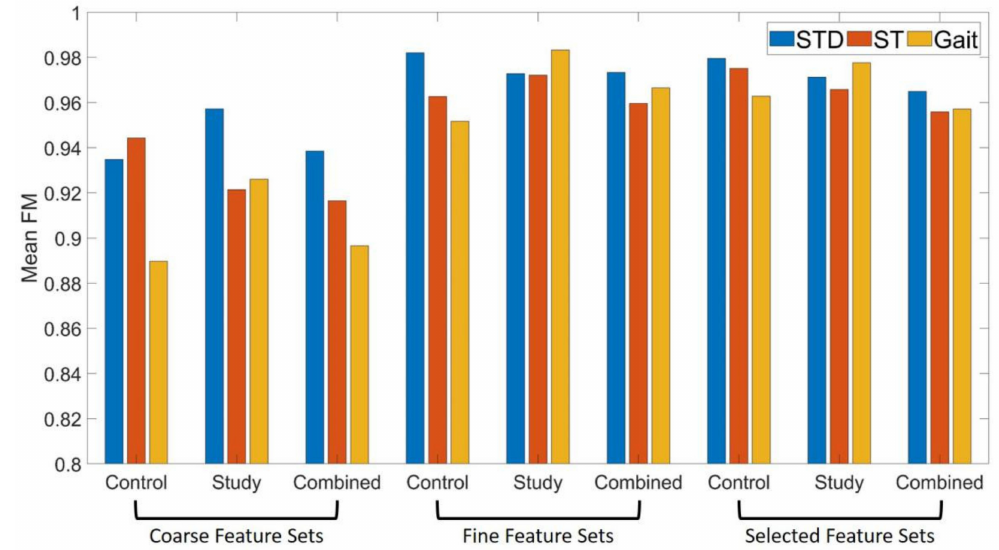
Figure 9. Mean F-measure per lower limb motion for different subject groups and feature